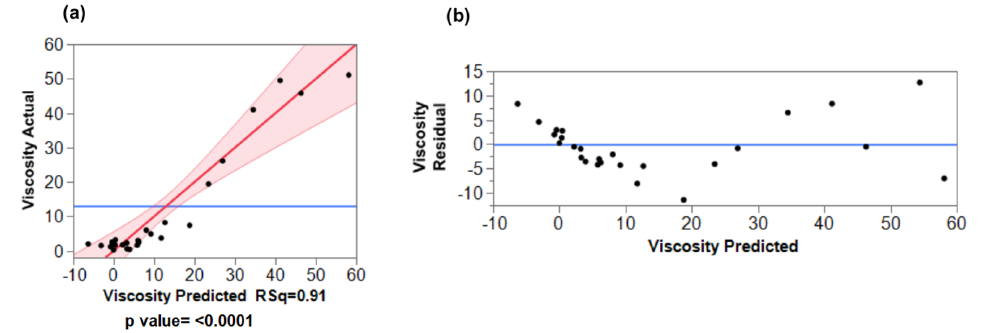
Figure 4. ( a ) Plots of actual versus predicted values of viscosity, ( b ) Plot of viscosity residual versus predicted values.